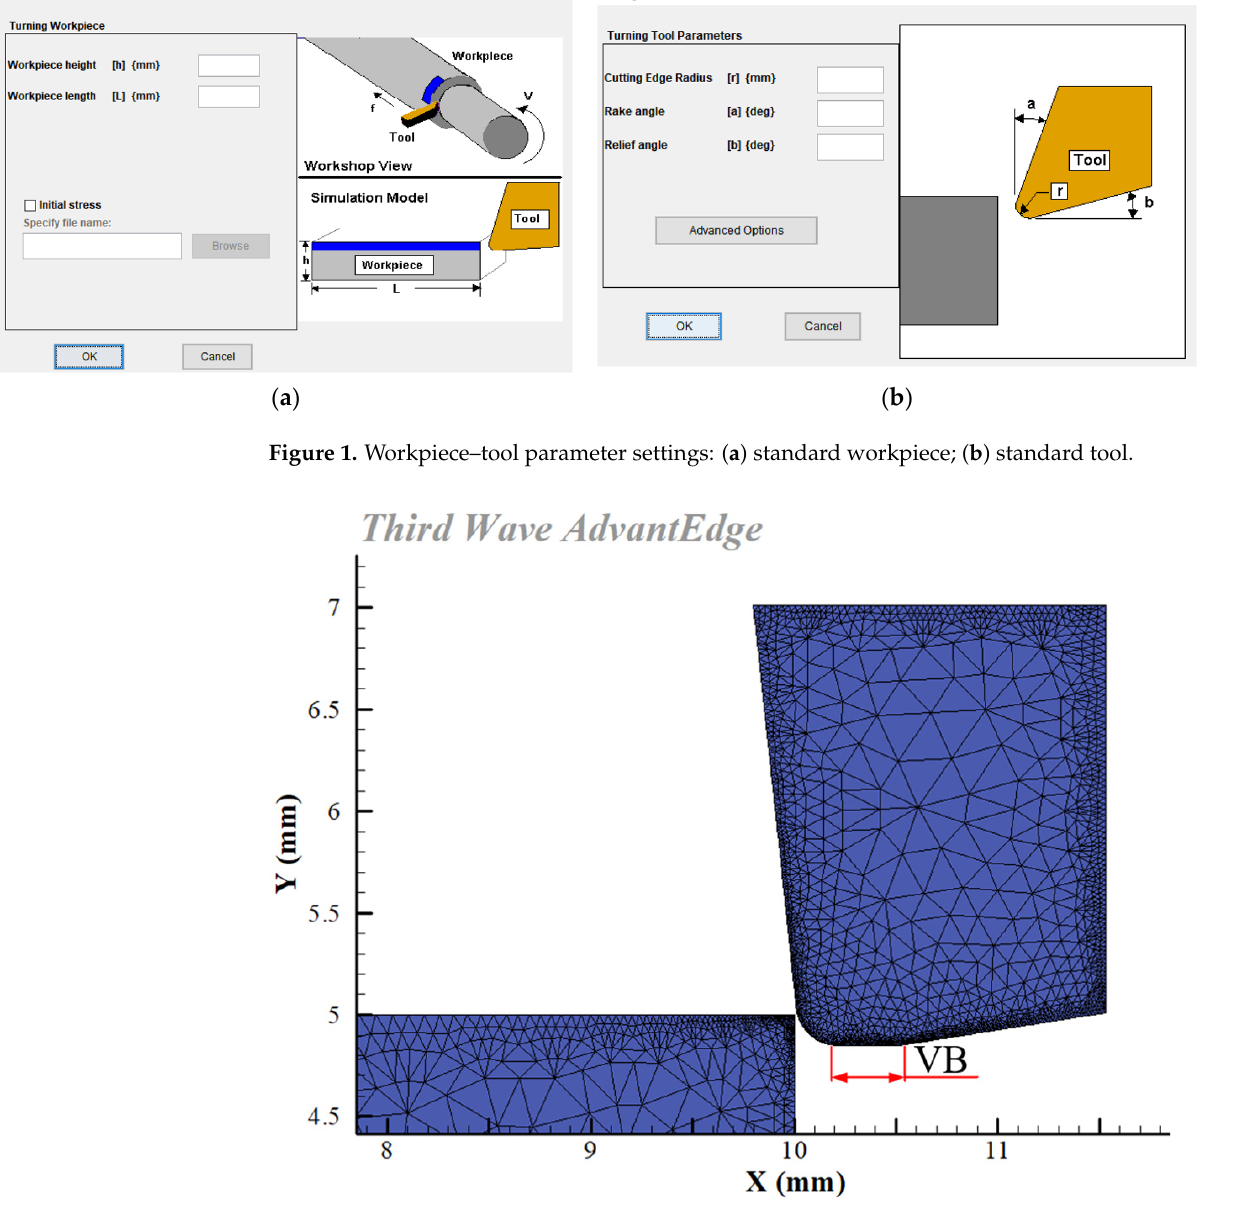
Figure 2. Two-dimensional simulation model of cu tt ing GH4169.